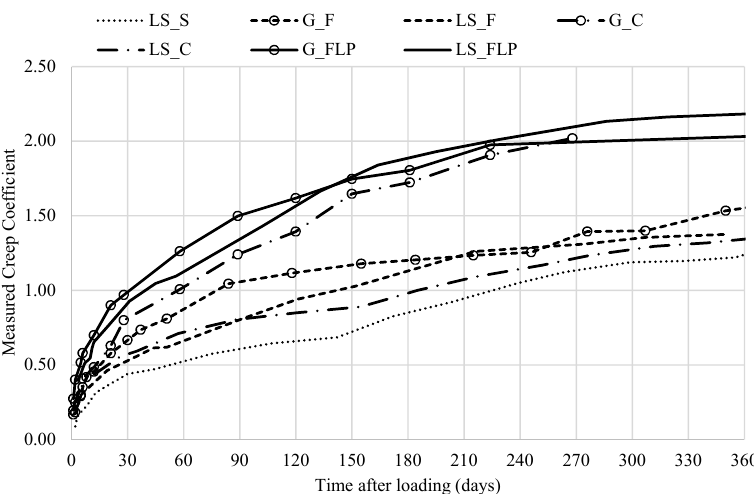
Figure 6. Measured creep coefficient versus time after loading for all SCC mixtures.